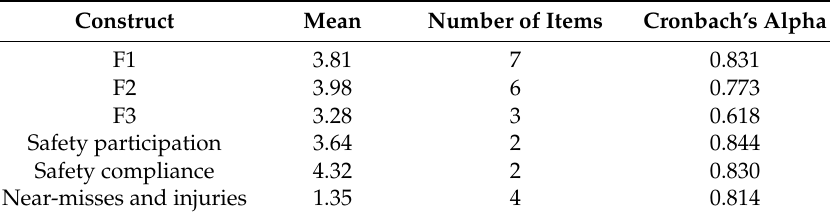
Table 3. Mean values and Cronbach’s alpha of